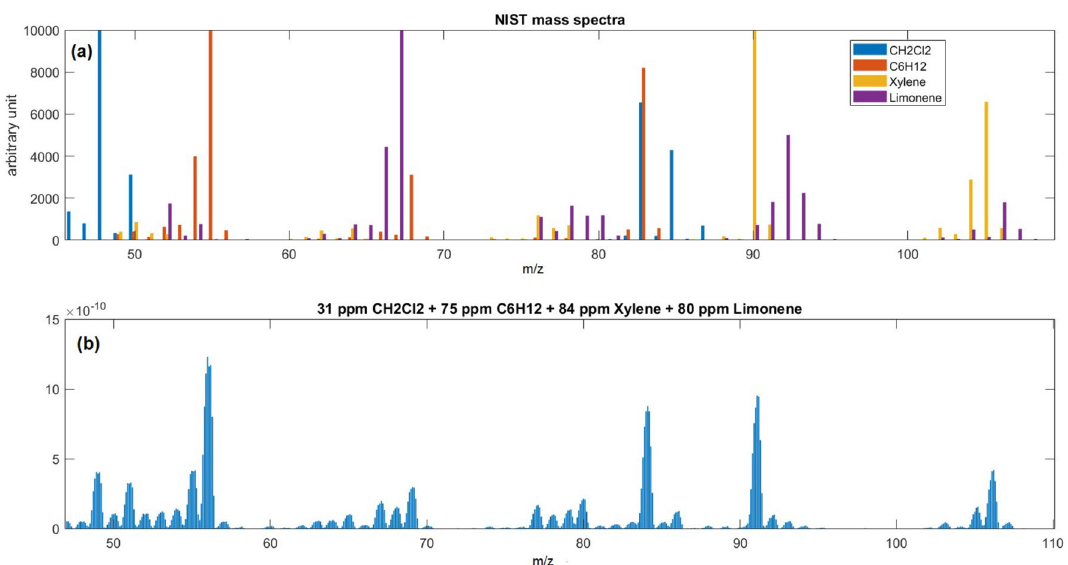
Figure 6. Mass spectra recorded in an interval of 47–110 u/e − . NIST mass spectra (at 70 eV Electron ionization energy) of CH 2 Cl 2 , C 6 H 12 , Xylene, and Limonene ( a ). Mass spectrum of a mix of 31 ppm of CH 2 Cl 2 , 75 ppm of C6H12, 84 ppm of Xylene, and 80 ppm of Limonene ( b